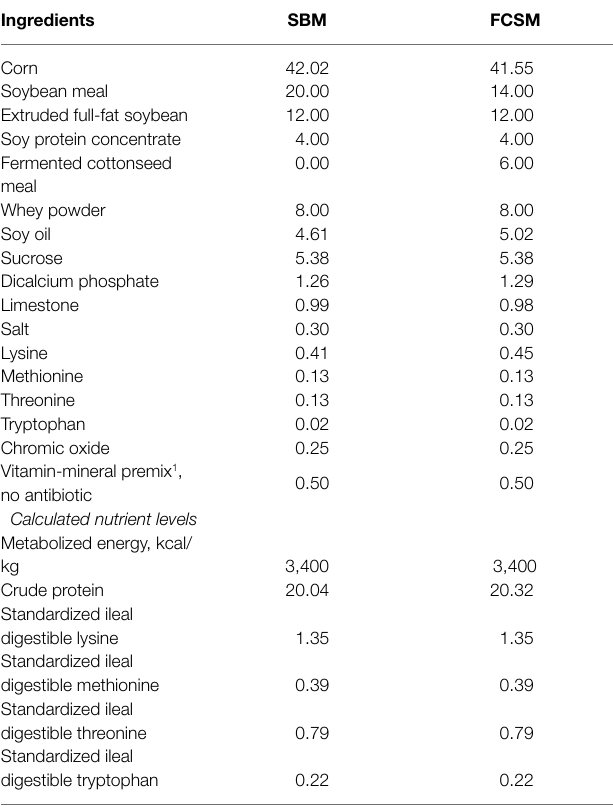
TABLE 1 | Analyzed composition of the fermented cottonseed meal and soybean meal (%, as-fed basis). Item SBM FCSM Dry